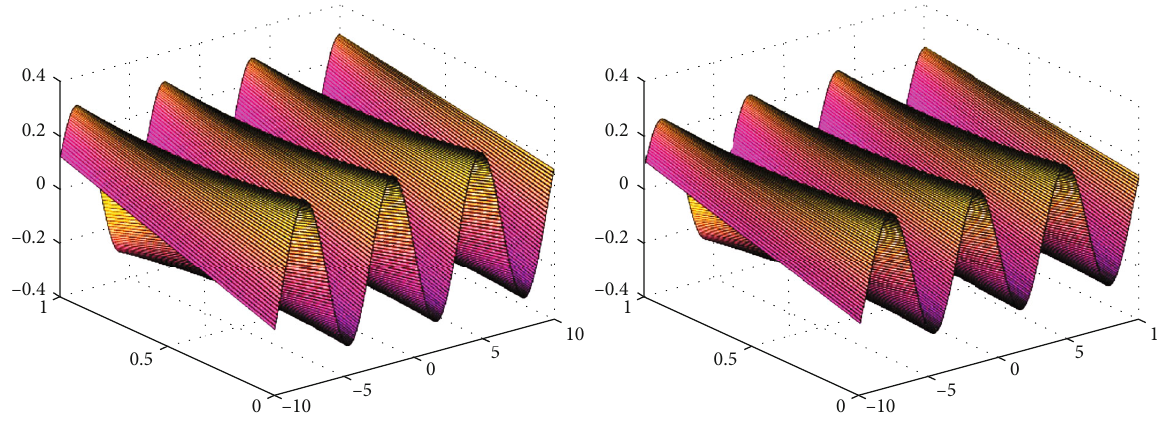
Figure 7: The fractional order of α = 0 : 8 and 0 : 6 of Problem 3.